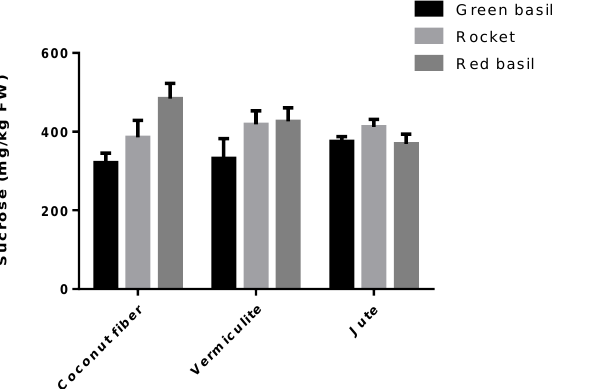
Figure 6. Sucrose concentration of green basil, rocket, and red basil microgreens grown on three different substrates. Values, subjected to two-way ANOVA, are means ± SE (n = 6).